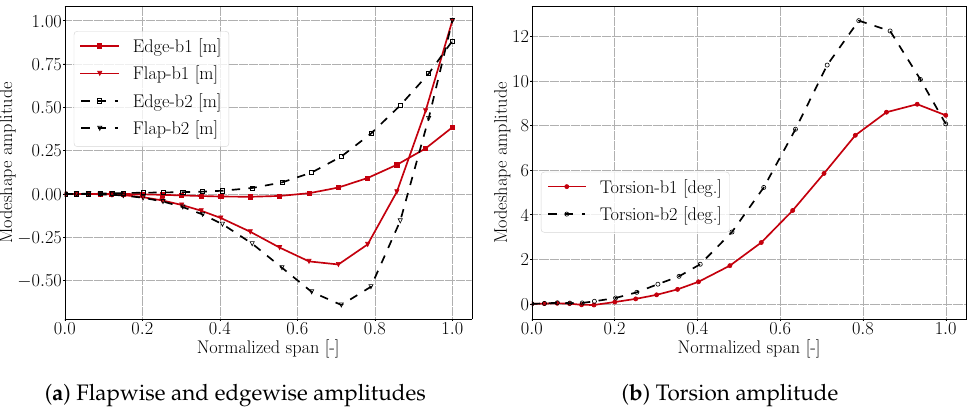
Figure 9. Third mode shape flapwise and edgewise shown in ( a ), and torsion amplitudes shown in ( b ) for both blade designs (Blade-1: b1, Blade-2: b2) (structural response only). Figure 10 shows the fourth mode shape amplitudes. Both blades have different main direction for the fourth mode shape; Blade-1 dominant direction is in the flapwise rotation which is not shown in mode shape plots. As a result of this fact, the flapwise motion has the largest amplitude among three direction for Blade-1. On the other hand, Blade-2 dominant direction is torsion for this mode shape and its strongly coupled with flapwise and edgewise motions. The torsion value at Blade-2 tip reaches 1 rad (57.3